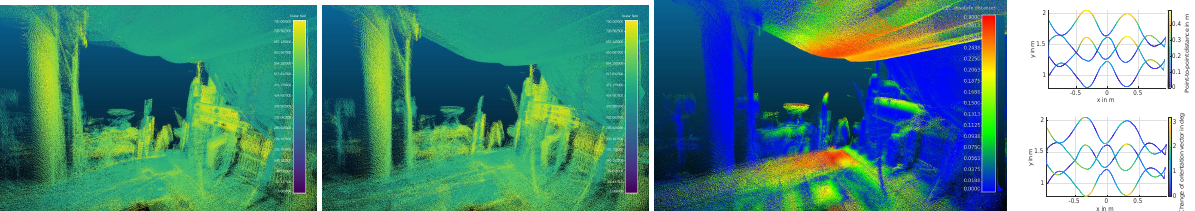
Figure 12. Sinusoid Distortion: Left: Input Point Cloud. Middle: Corrected point cloud. Right: Error between corrected and reference point cloud. Plots: Above: Point to point distance between the corrected and original trajectory. Below: Change of orientation vector between the corrected and original trajectory.